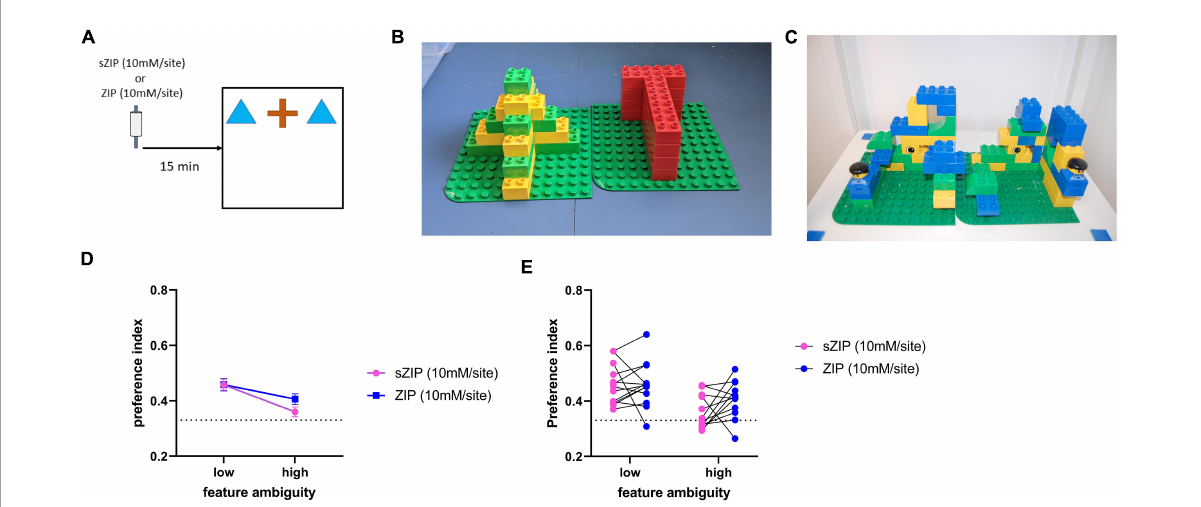
FIGURE2 Performance in the perceptual oddity task is not altered by ZIP infusion into the perirhinal cortex. (A) Outline of the perceptual oddity task used, ZIP was infused into PRH 15 min before the task commenced. (B) Example of low and (C) high feature ambiguity objects used in the perceptual oddity task. (D) Performance in the perceptual oddity task was not altered in either the low or high feature ambiguity condition by infusion of ZIP, dotted line indicates chance performance levels, data presented as mean ± sem. (E) Performance of each individual animal after infusion of sZIP or ZIP on both high and low feature ambiguity conditions. Dotted line represents chance performance (0.33). Low feature ambiguity n = 13 for both sZIP & ZIP, high feature ambiguity n = 12 for both sZIP and ZIP.